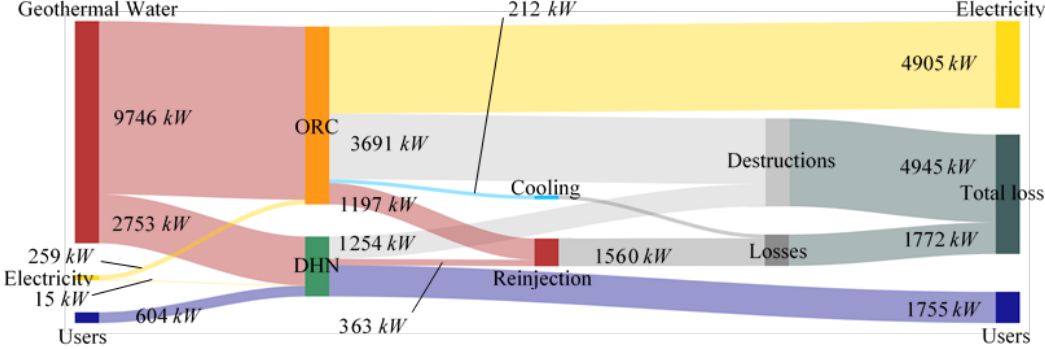
Figure 6. Exergy flow for min𝐸̇𝑥 𝑙𝑜𝑠𝑠 .